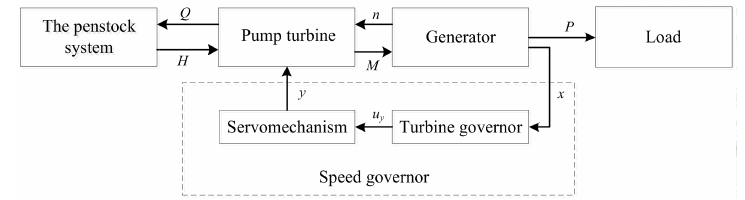
Figure 1. A simple structure of